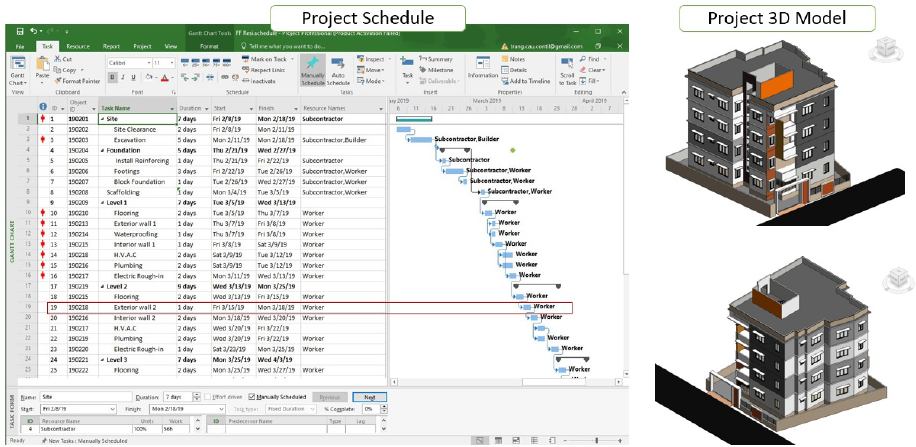
Figure 8. Residential building